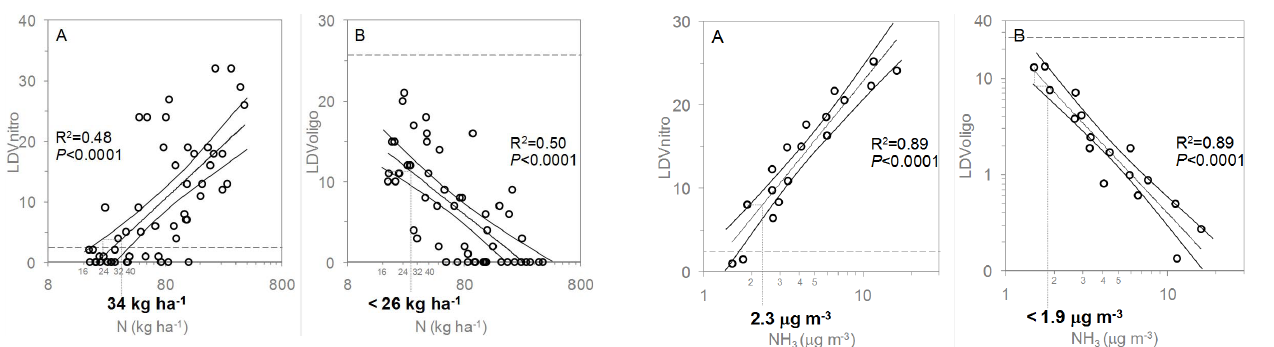
Fig. 4. Critical levels of atmospheric ammonia considering the ni- trophytic (A) and oligotrophic (B) functional groups. The [NH 3 ] atm were measured for one year and correlated to changes of LDVnitro (nitrophytic) and LDVoligo (oligotrophic). Considering the confi- dence intervals of the regression line (95%) and the first point with a LDV different from the control values (dotted lines) the critical level was established. Because the observed values of LDVoligo are below the control value, a critical level lower than 1.9µgm − 3 should be